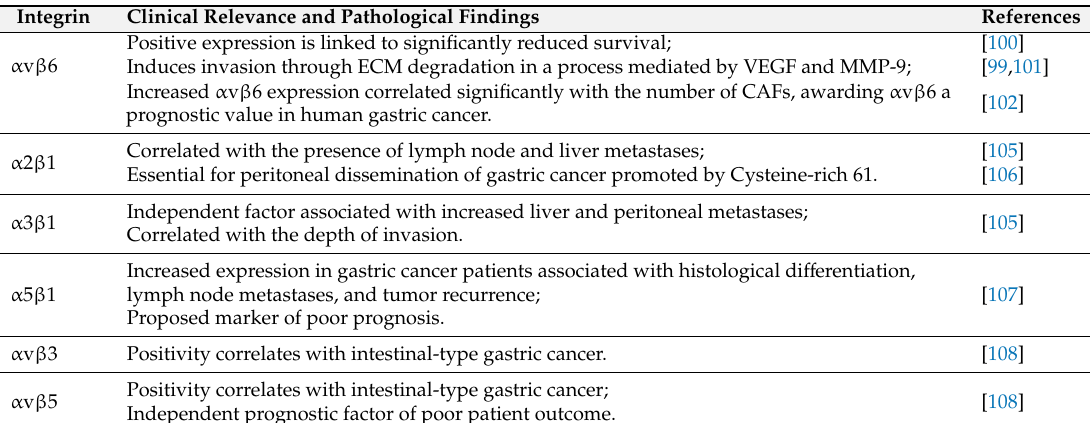
Table 2. Integrins abnormally expressed in gastric cancer. Depiction of reported integrins with aberrant expression pattern in gastric cancer and their clinical relevance. Integrin Clinical Relevance and Pathological